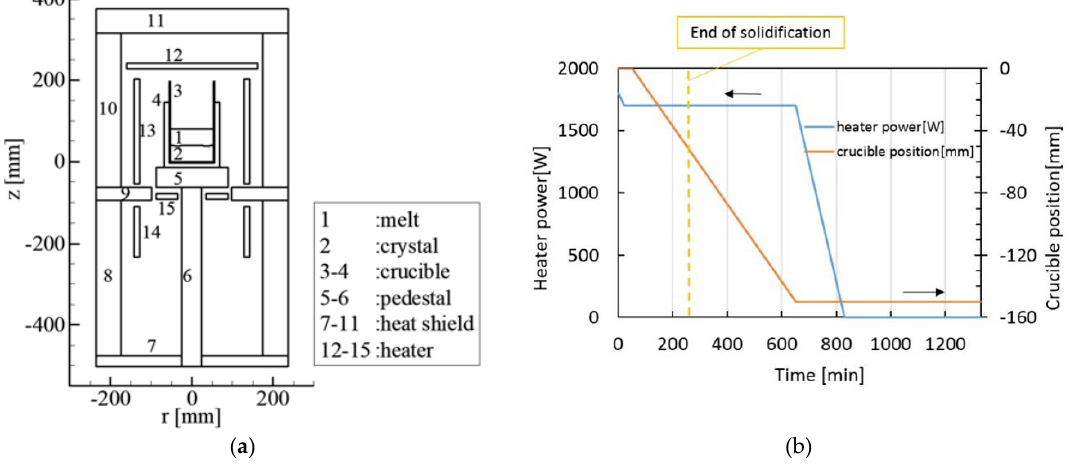
Figure 2. The structure of the furnace: the melt (1), the crystal (2), a quartz crucible (3, 4), pedestals (5, 6), heat shields (7–11), and four heaters (12–15) ( a ), and the history of crucible position and heater power during the solidification process and the cooling process ( b